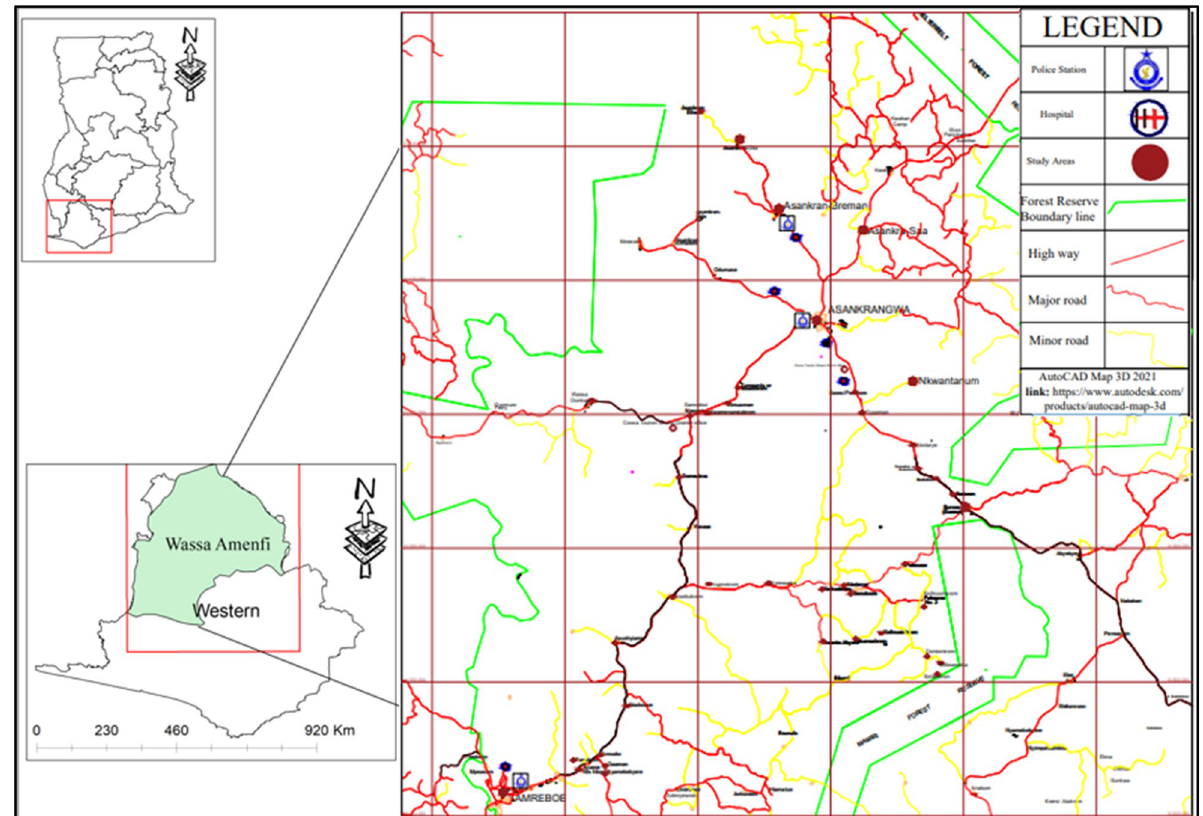
Figure 1. Map of the Amenfi West Municipal and Study